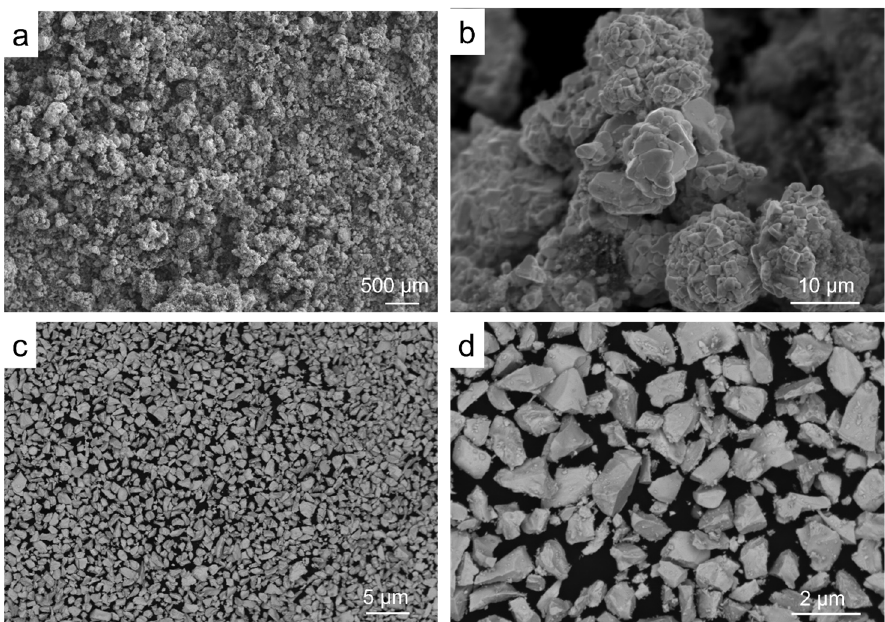
Figure 8. WC after carbidization ( a , b ) and after ball milling ( c , d ).